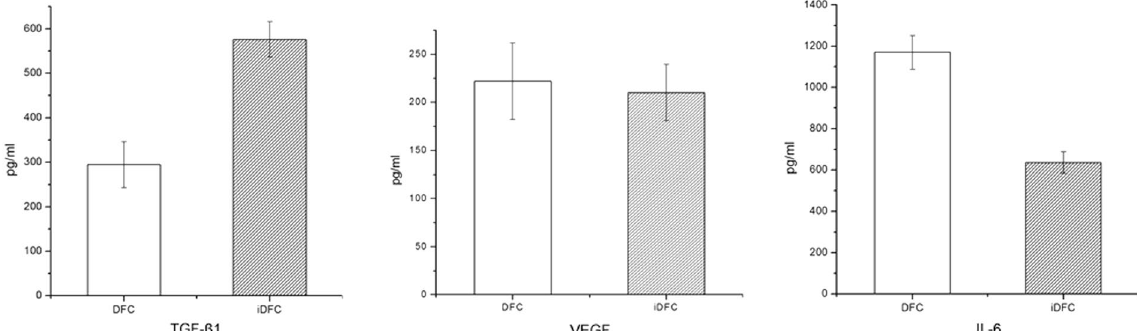
Figure 5. Concentration of cytokines in the CM of DFCs and iDFCs. Secretion of TGF- β 1 increased in iDFCs compared to DFCs; Secretion of IL-1 decreased in iDFCs compared to DFCs; Secretion of VEGF didn’t significantly differ between DFCs and